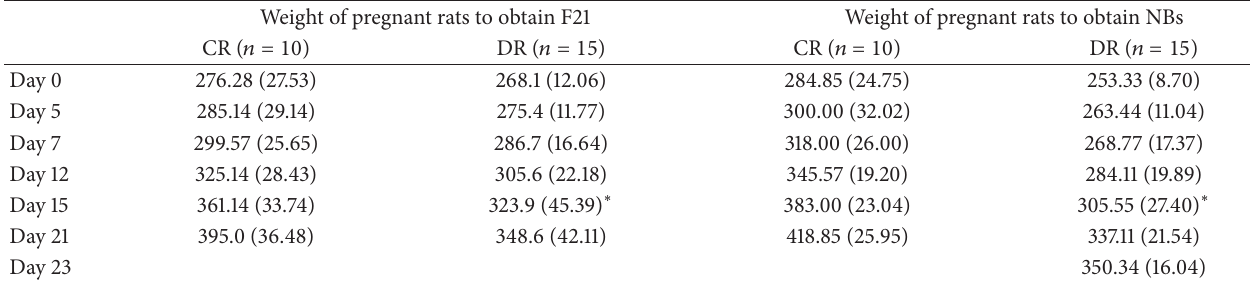
Table 3: Body weight of pregnant rats (in grams).